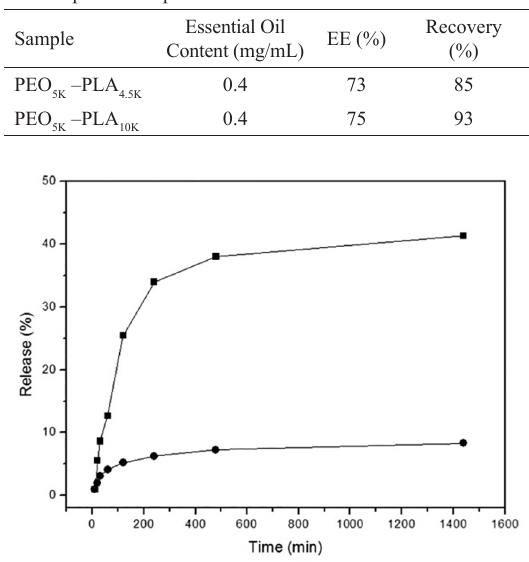
Figure 7: Releasing profile of nanoparticles containing 10% lavender essential oil: (■)PEO